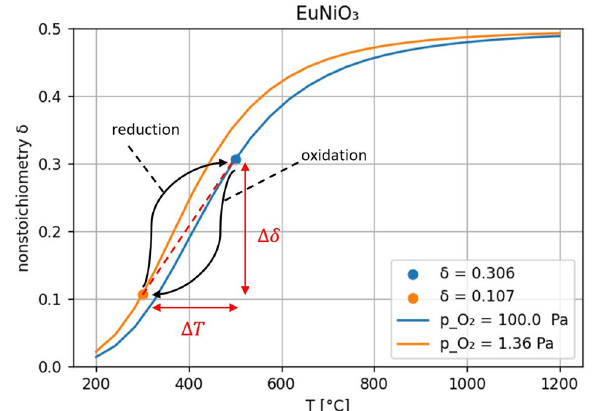
Figure 3. Two non-stoichiometry equilibrium curves of EuNiO 3 perovskite, end points of reduction and oxidation reactions, temperature and non-stoichiometry delta